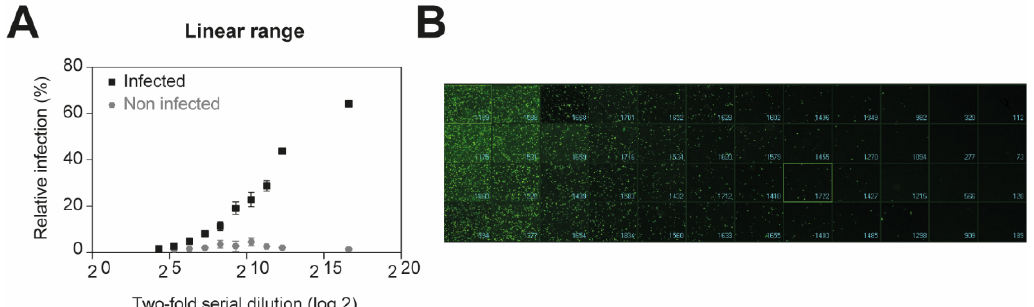
Figure 1. Determination of linear range for luminescent detection. Confluent monolayers of A549 cells were infected with two-fold serial dilution of VSV* Δ G-Luc(VSV-G) in DMEM 10% FCS for 16 h at 37 °C under 5% CO 2 . EGFP-positive infected cells were measured by high-content imaging. ( A ) Quantified representation of EGFP-expression. ( B ) Representative images of reporter virus-infected A549 cells. Images for two-fold serial dilutions are presented.